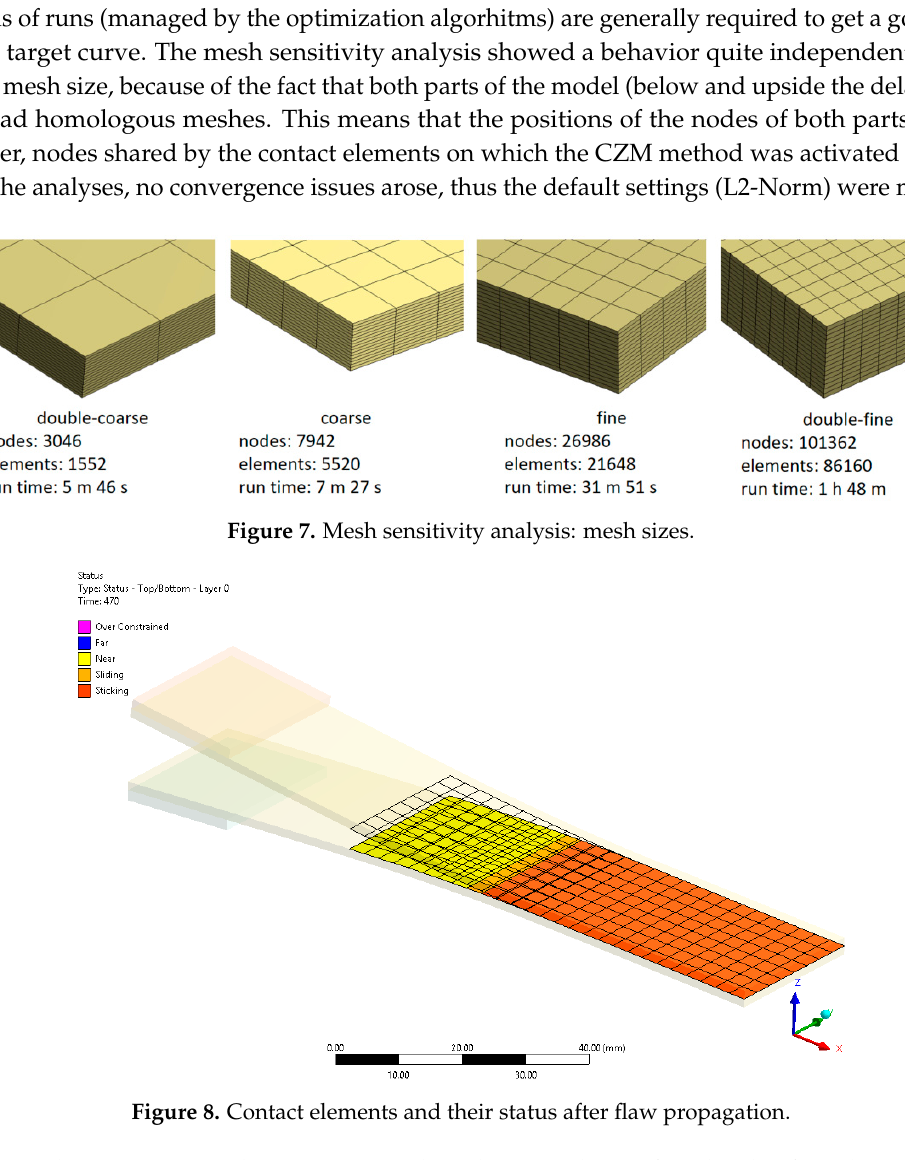
Figure 9 . Mesh sensitivity analysis: result comparison . In Figure 10, the debonding area is highlighted. Following the recommended procedure for fracture mechanics, after the bonded contact set up, all cohesive properties were applied using fracture mechanics options in the highlighted area.